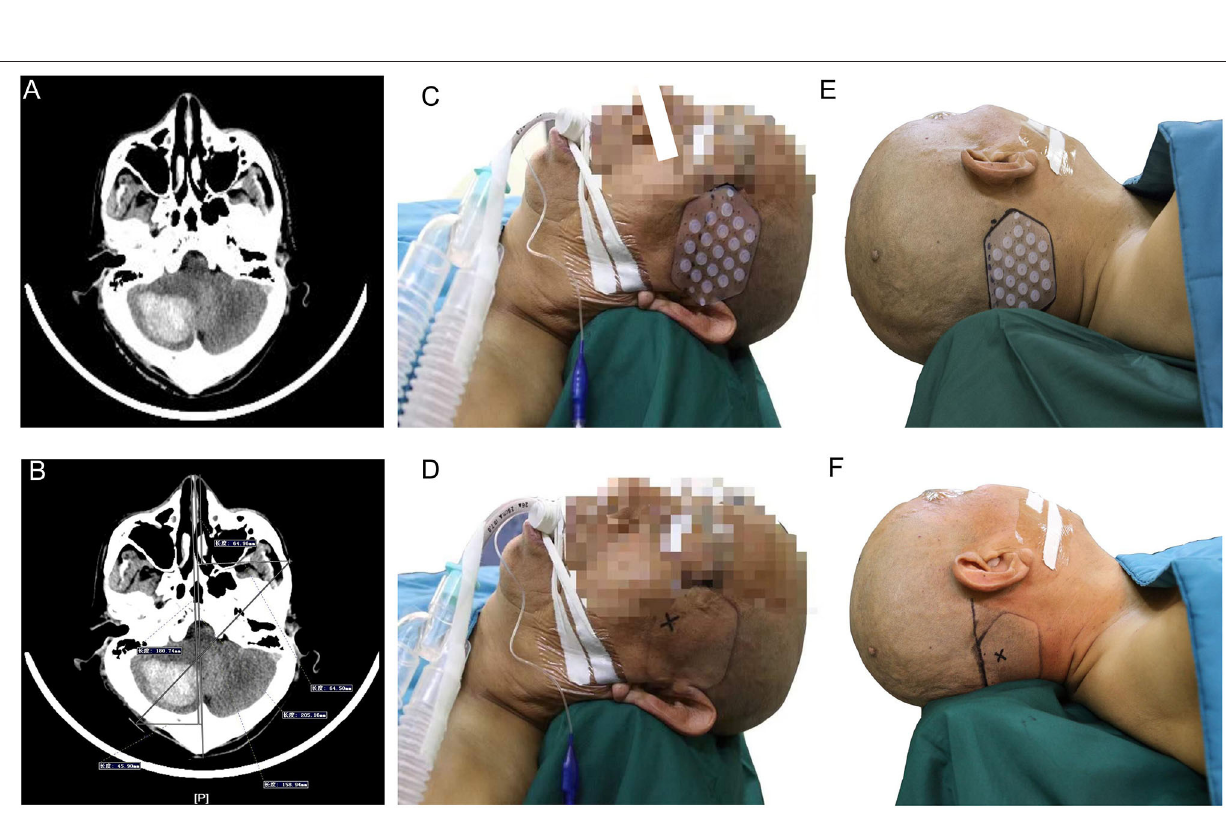
Frontiers in Neurology |